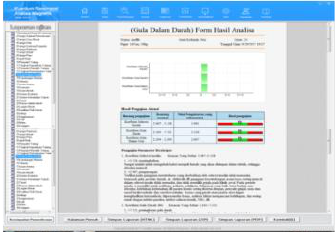
Figure 3. Display of the QRMA analysis results related to blood sugar level